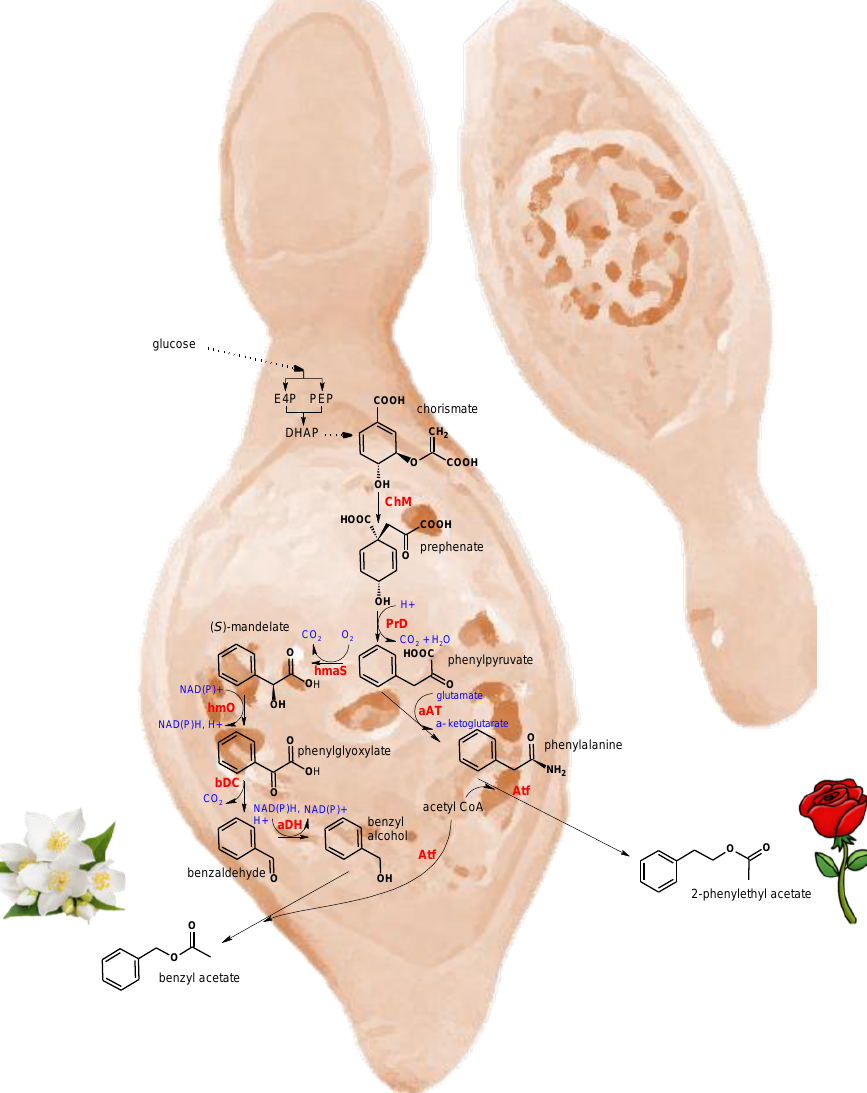
Figure 3. Metabolic pathways involved in the de novo synthesis from sugars of floral esters by H. vineae following the chorismate-prephenate-( S )-mandelate / phenylalanine pathway ( ChM: chorismate mutase, PrD: prephenate dehydratase, hmaS: hydroxymandelate synthase, hmO: hydroxymandelate oxidase, bDC: benzoylformate decarboxylase, aDH: benzyl alcohol dehydrogenase; aAT: aromatic aminotransferase; Atf: acyltransferase). Adapted from [36,38,39].